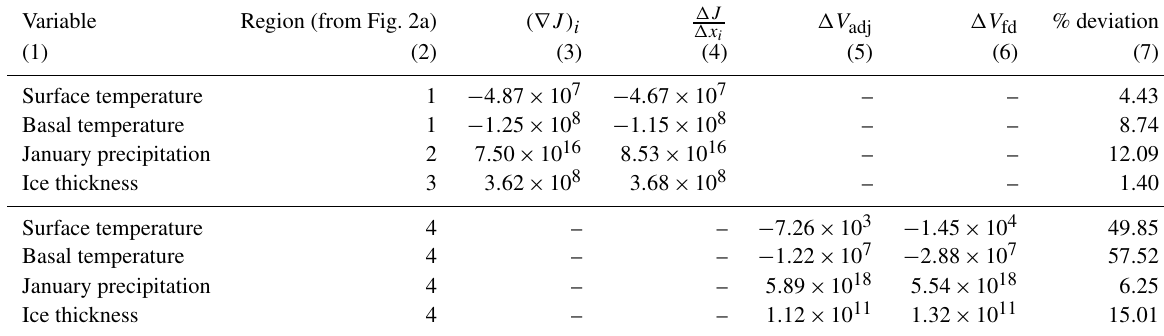
Table 1. A sample of comparisons between adjoint-derived and finite-difference-based sensitivities. All regions in column (2) refer to either selected point-wise perturbations δx i = (cid:15) e i (with unit vector e i of the i th component) or perturbations applied over an extended box delineated in Fig. 1a. Columns (3) and (5) are adjoint-derived quantities, while columns (4) and (6) are derived via finite-difference perturbations either at a single point in the domain or integrated over a patch, as shown in Fig. 2a. Validation of the adjoint model is sought by comparing finite differences (4) and adjoint values (3) in a percent deviation metric (7). Column (7) is calculated as Point-wise ice thickness as well as surface and basal temperatures compare well, with a percent deviation of less than 10%. Summer precipitation has a higher disagreement, at 12%. Patch-wide comparisons have a considerably higher percent deviation. We also performed a test for the Greenland Ice Sheet, shown in more detail in Appendix